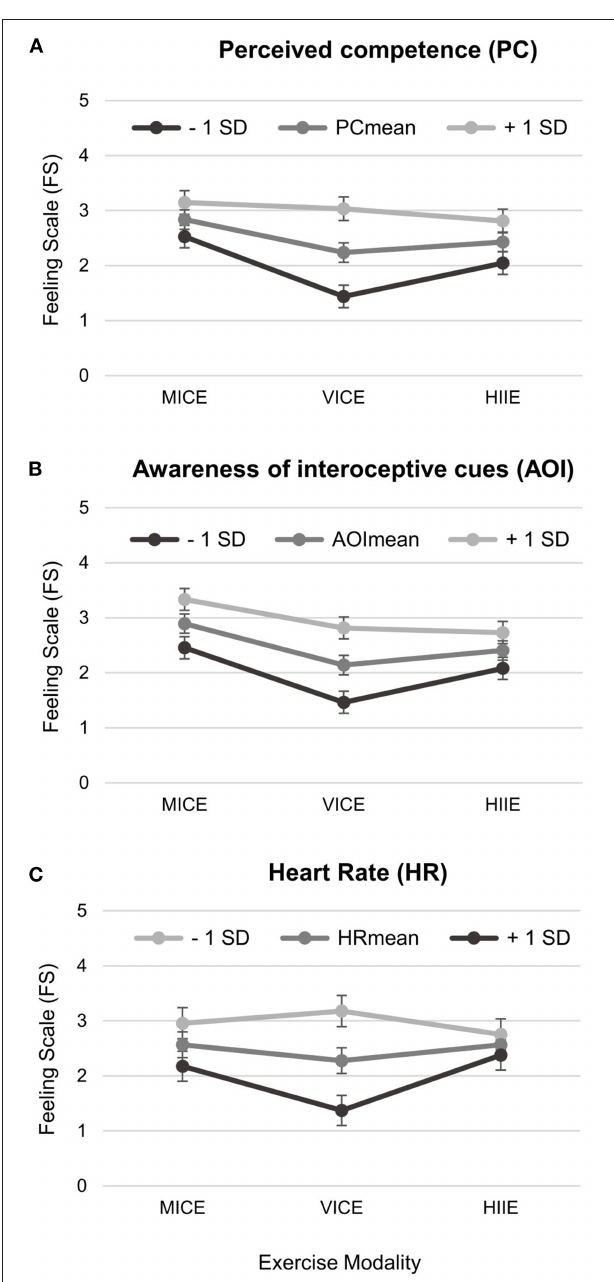
FIGURE 5 | Two-way interaction plots of psychophysiological predictors of in-task (t 1 , t 2 ) affective valence (Models 3a-c): (A) Perceived competence, (B) Awareness of interoceptive cues, and (C) Heart rate. Shown is the respective expression of the Feeling Scale (FS) for the mean value of the predictor as well as for one standard deviation below the mean value ( − 1 SD) and for one standard deviation above the mean value ( + 1 SD) with error bars representing standard errors. MICE, moderate-intensity continuous exercise; VICE, vigorous-intensity continuous exercise; HIIE, high-intensity interval exercise.